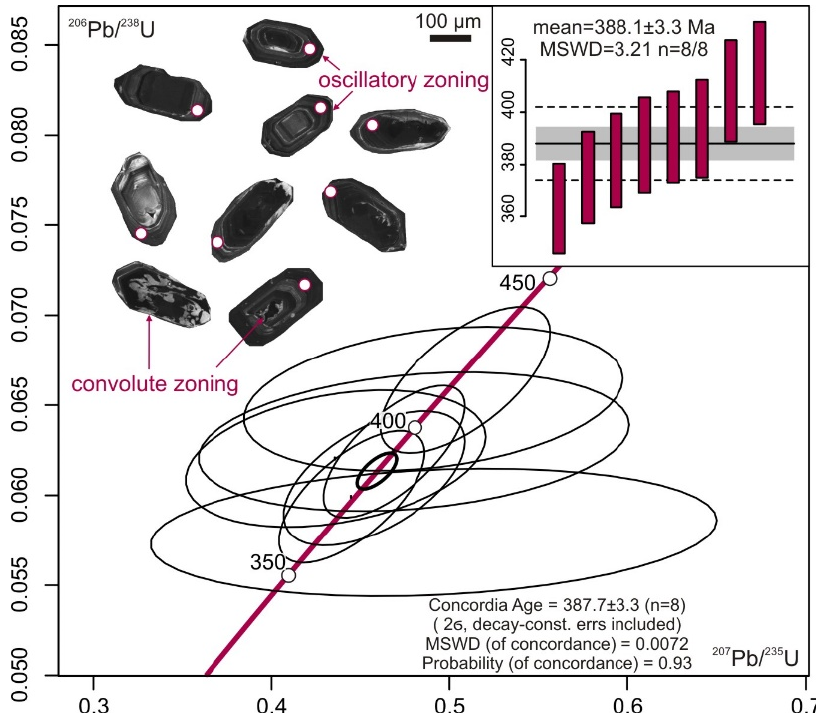
Figure 5. U-Pb isotope Concordia (Wetherill) plot, single-grain, and weighted mean 206 Pb/ 238 U ages for zircons from the sample of granite (2013). Internal structure of the zircon grains is in cathodoluminescence images. MSWD is given for concordance. Table 1. U-Pb results (all errors are 2 σ